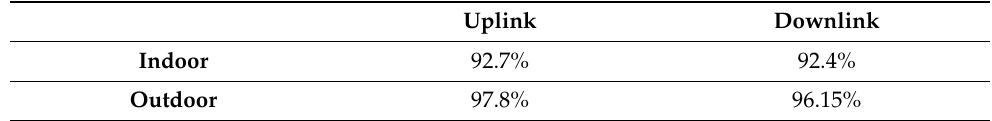
Table 1. Packet delivery ratio (PDR) in indoor and outdoor